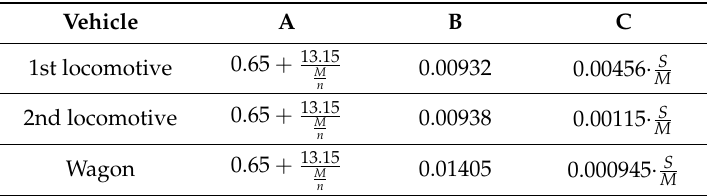
Table 1. Davis’ equation coe ffi cients